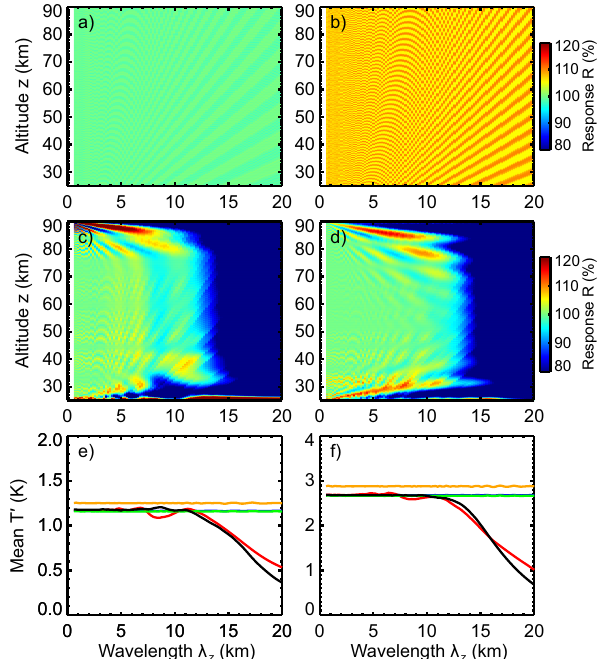
Figure 2. Spectral response of different methods of determining temperature perturbations as a function of vertical wavelength λ z : nightly mean (a) , 3h running mean (b) , sliding polynomial fit (c) and Butterworth filter (d) . (e) and (f) depict mean extracted tem- perature perturbations in the ranges 30–40km (e) and 50–60km (f) as well as the simulated temperature perturbations (blue line). The different methods are color-coded as follows: nightly mean – green; 3h running mean – orange; sliding polynomial fit – red; Butterworth filter – black. Please note that the blue line in this case lies exactly underneath the green line. All simulations were carried out with τ = 1.9h and a background temperature profile constant in time.